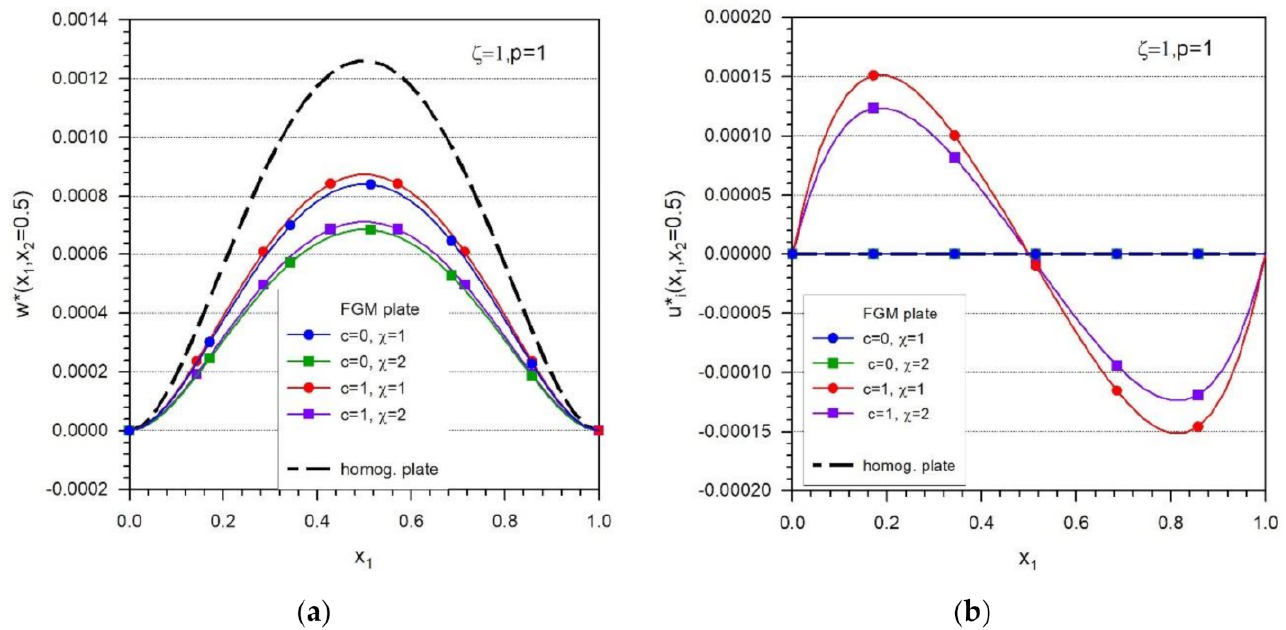
Figure 6. ( a ) Deflections and ( b ) in-plane deformations in homogeneous as well as FGM plates.